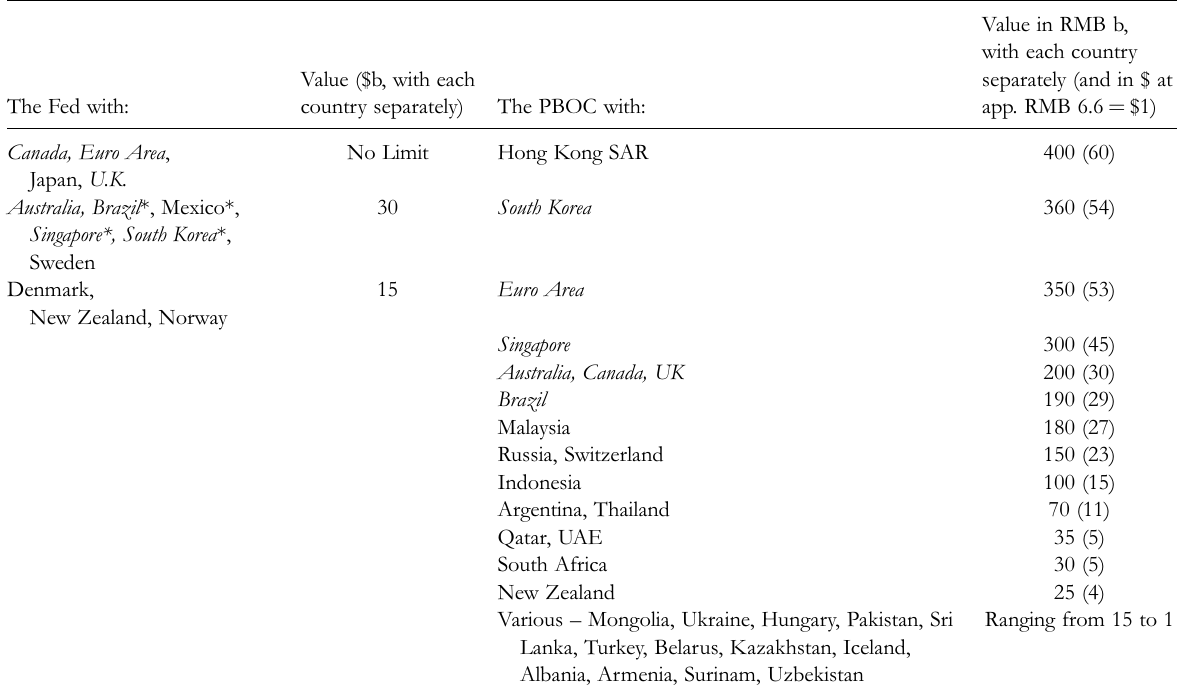
Table 2: The Fed ’ s and People Bank of China ’ s Swap Arrangements The Fed with: